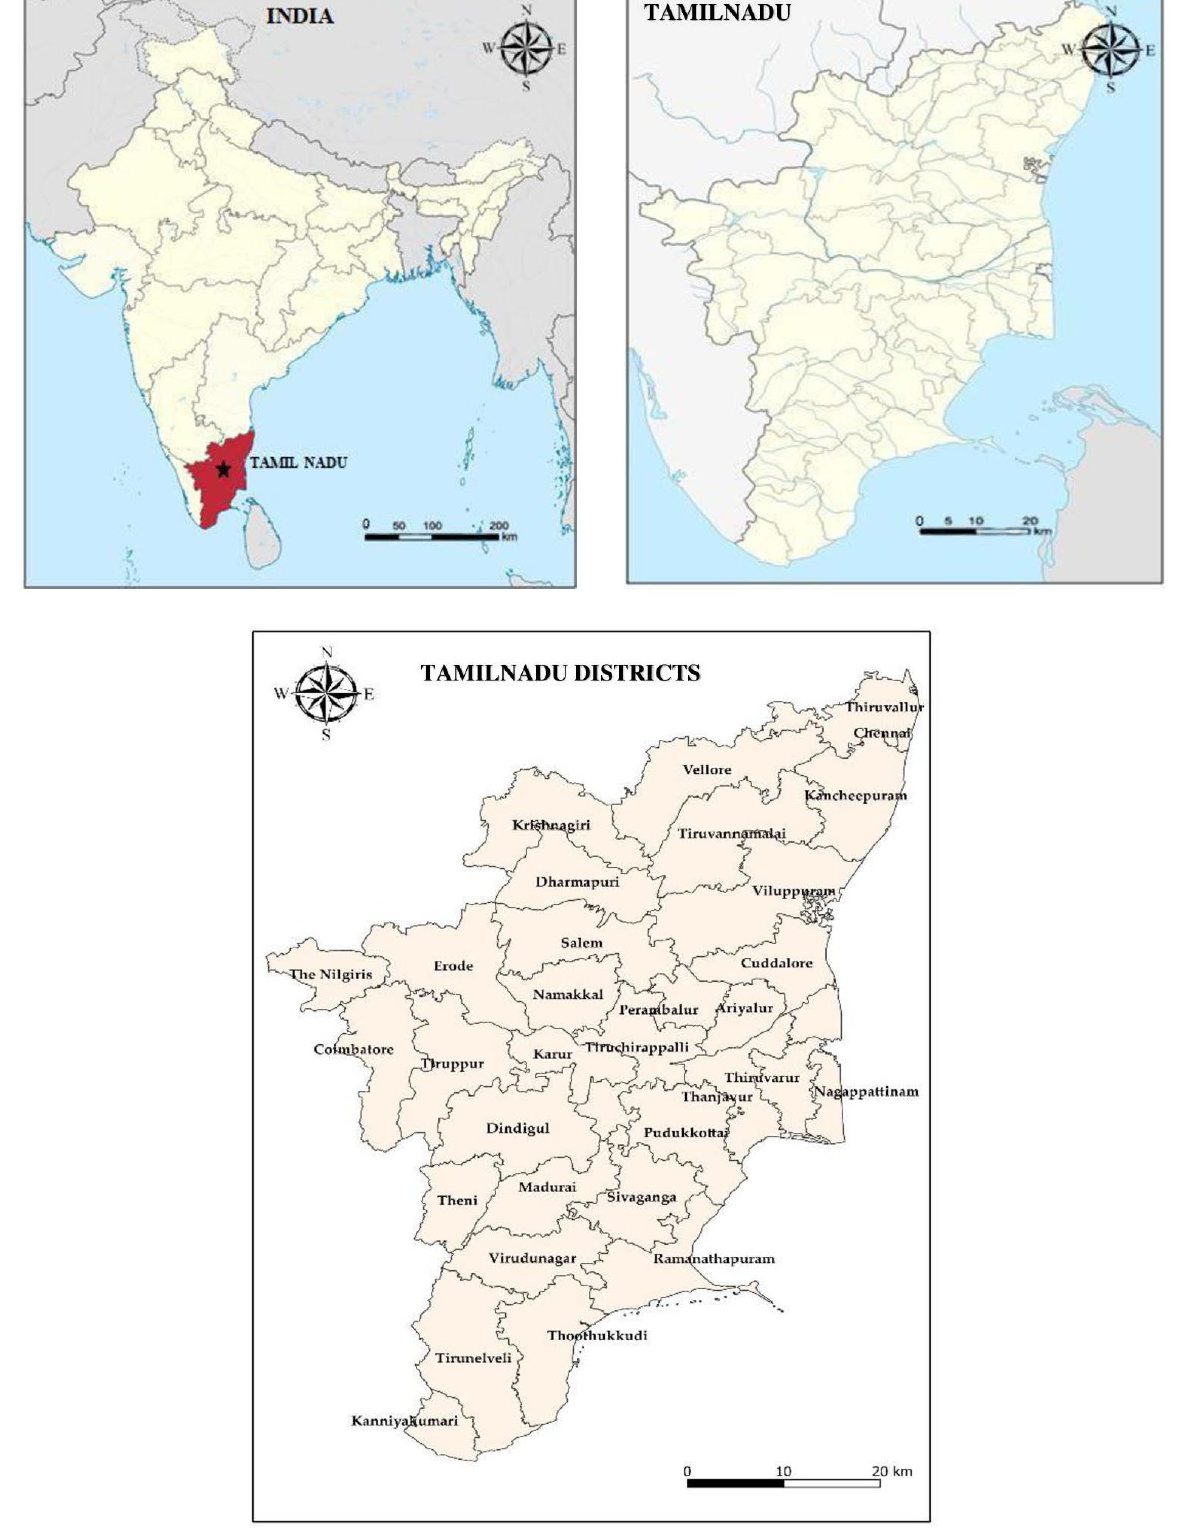
Figure 1. Geographic location and area of Tamil Nadu State. The maps were generated using Google Maps.